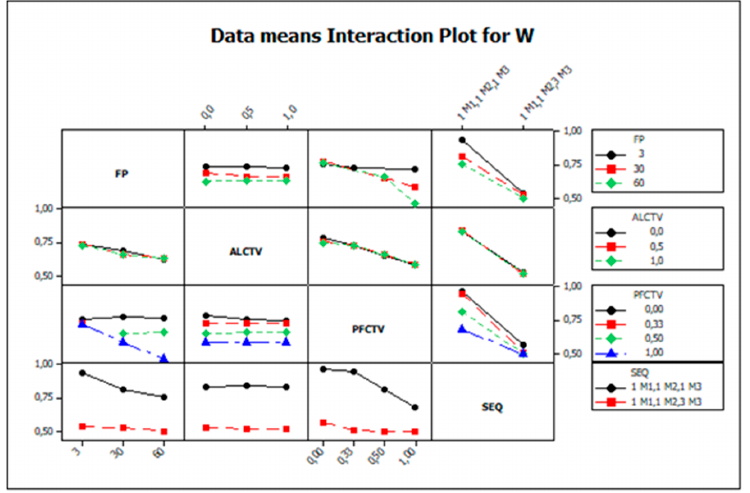
Figure 7. Interaction plot of the input parameters FP, ALCTV, PFCTV, SEQ for W.